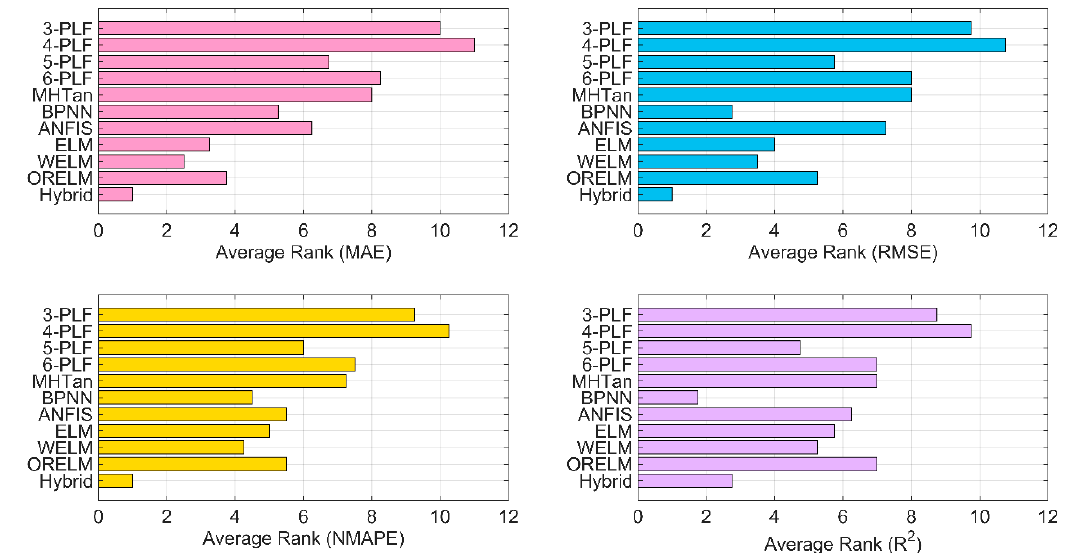
Figure 4. Averages ranks of different models on all datasets based on four error indicators.